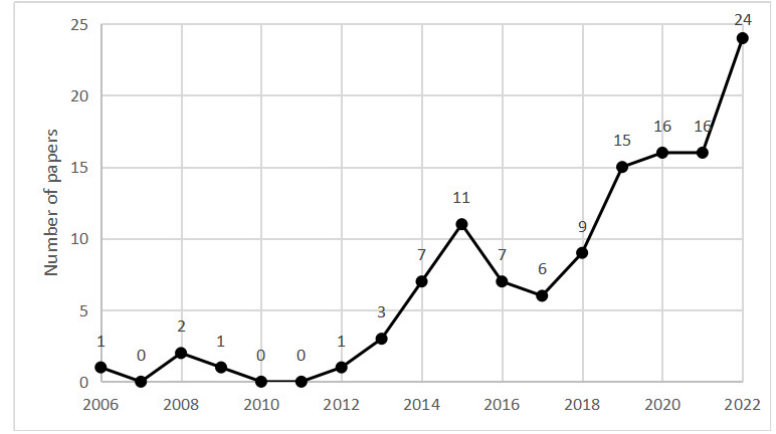
Figure 1. Numbers of papers from 2006 to 2022.